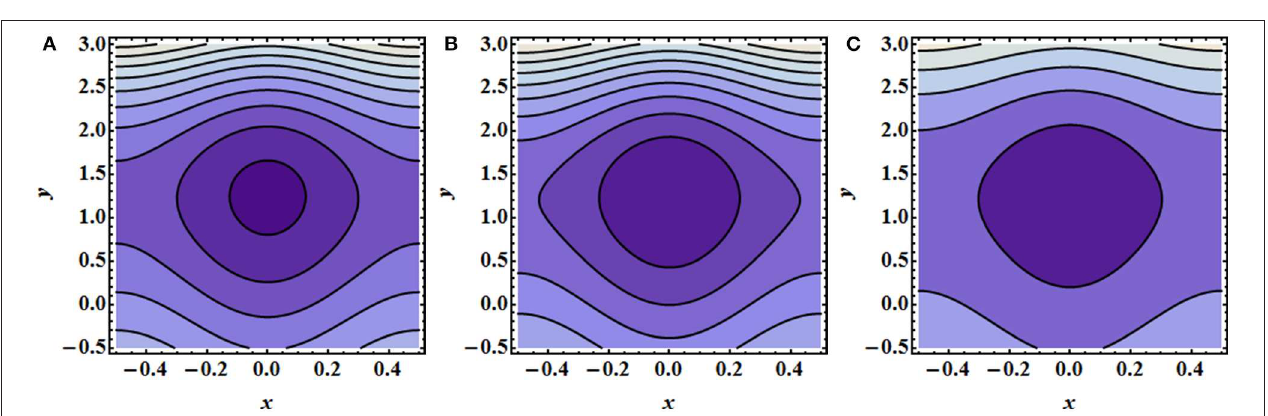
FIGURE 11 | Trapping variation for particulate phase when N 1 = 3, φ = 0.04, Q = 1, B = 0.1, A = 0.1, C = 0.03. (A) k = 3.1, (B) k = 3.2, and (C) k =